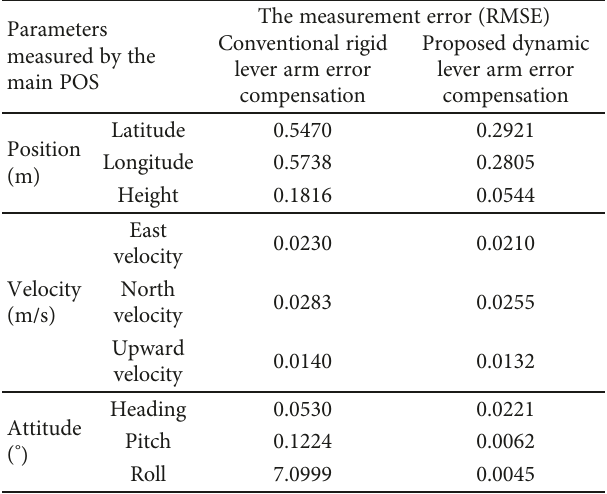
Table 4: Measurement error comparison of the second-level dynamic lever arm error